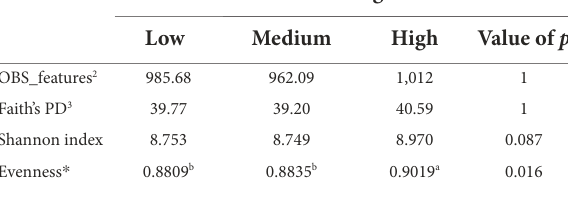
TABLE 3 Alpha-diversity indices calculated for the fecal samples of Holstein dairy cattle with different somatic cell count ranges (SCC) at time of collection: low, medium, or high.